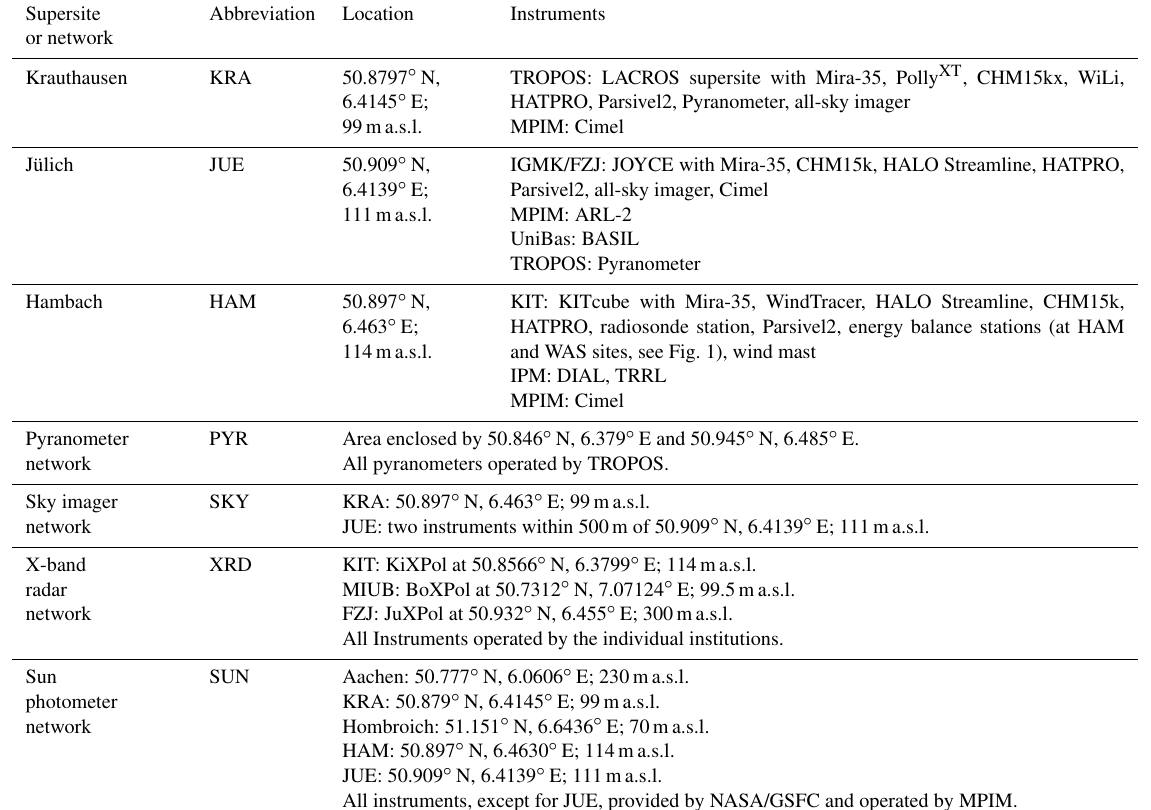
Table 1. Sites and networks deployed during HOPE-Jülich. Information on the individual instruments are given in Table 2. For details on the affiliations see Sect. 2.1.1. as well as the title page of this article.